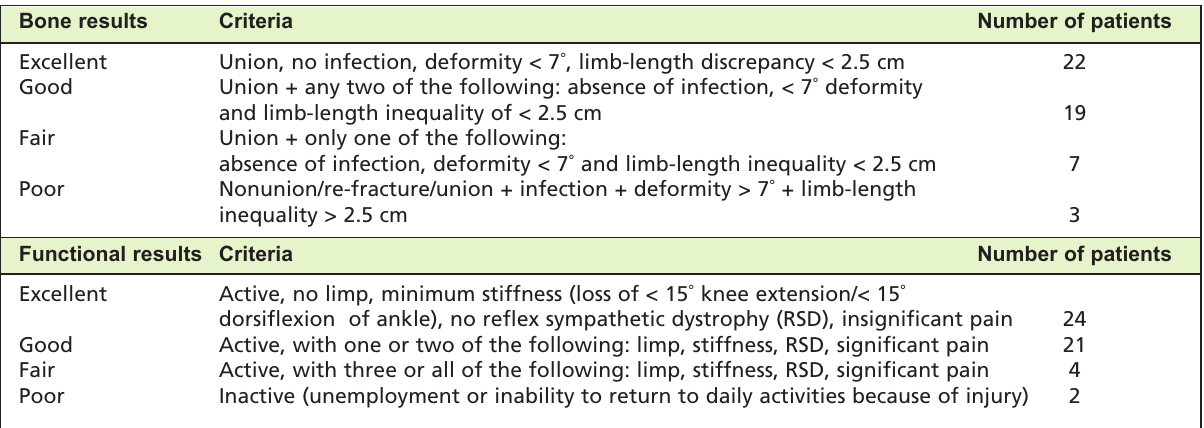
Bone and functional outcomes using Association for the Study and Application of the Methods of Table IV: Ilizarov (ASAMI) system Bone